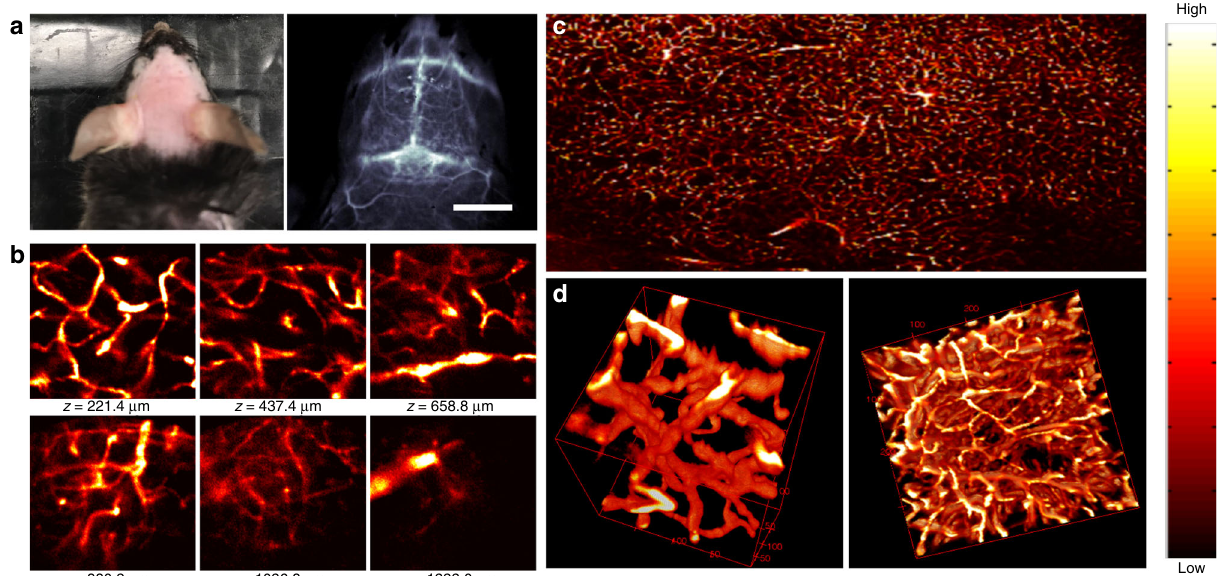
Fig. 3 Ex vivo confocal imaging of brain vasculatures of a mouse injected with p-FE. a Photo and wide- fi eld NIR-II epi- fl uorescence imaging of brain in a mouse injected with p-FE (808 nm excitation, emission >1200 nm) with exposure time of 5 ms. b – d Ex vivo confocal imaging of brain in a mouse injected with p-FE (785 nm excitation, emission >1100 nm, laser power ~30 mW, PMT voltage ~500 V). b Small area (200 × 200 µ m, x × y , step size: 1 µ m) and c Large area (3000 µ m × 2000 µ m, x × y , step size: 1 µ m). The deepest area could reach ~1350 µ m. d 3D reconstruction of vasculatures in brain: small area (left side, 200 µ m × 200 µ m × 200 µ m, x × y × z , step size: 1 µ m along x, y , and z directions, galvo mirror scanning, scanning speed: 2 s/frame) and large area (right side, 400 µ m × 400 µ m × 400 µ m, x × y × z, step size: 2 µ m along x and y directions, 2.7 µ m along z direction, stage scanning, scanning speed 7.5 min frame − 1 ). Scale bar represents 6